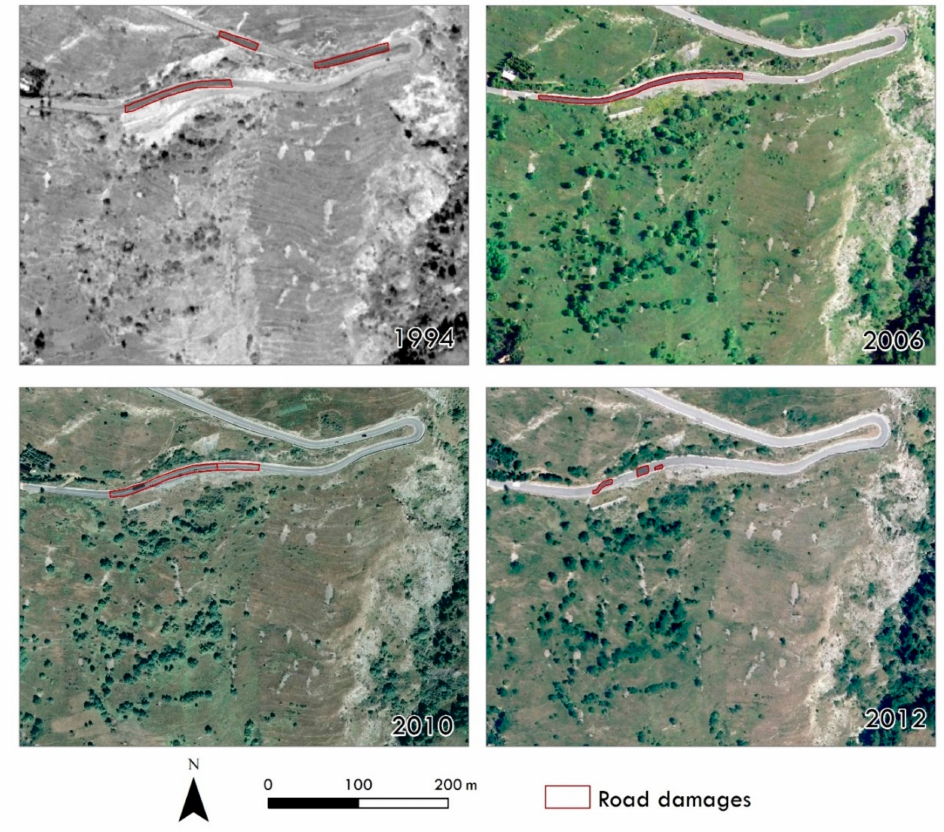
Figure 13. a. Evidence of road repaving visible on the orthoimages available on the “ Portale Cartografico Nazionale ” web-portal